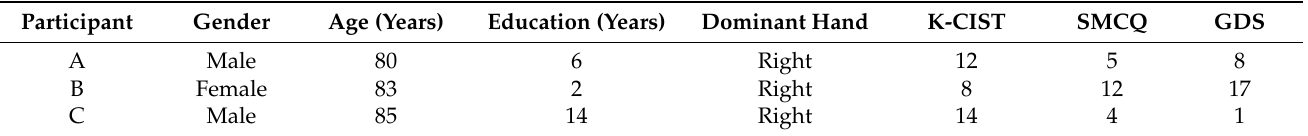
Table 1. Participants’ demographic